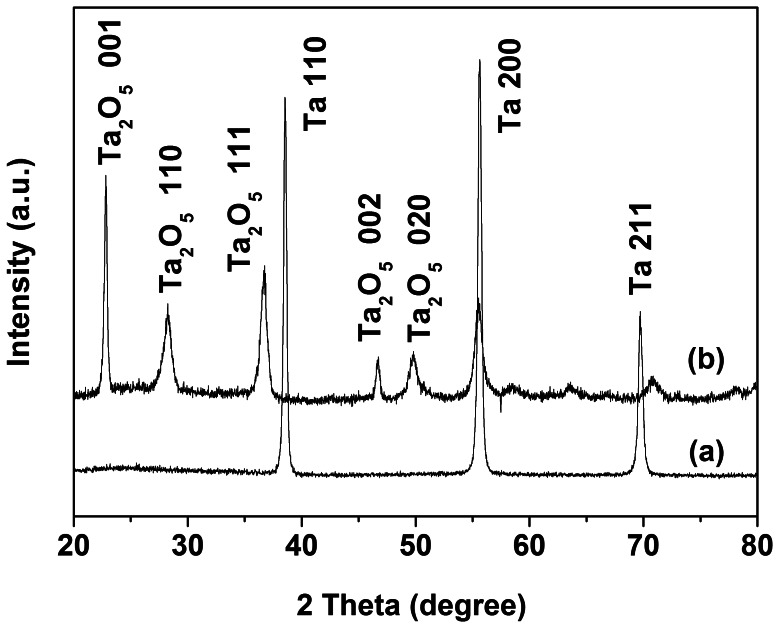
XRD patterns of (a) the as-prepared coral-like Ta2O5 and (b) the calcined sample.